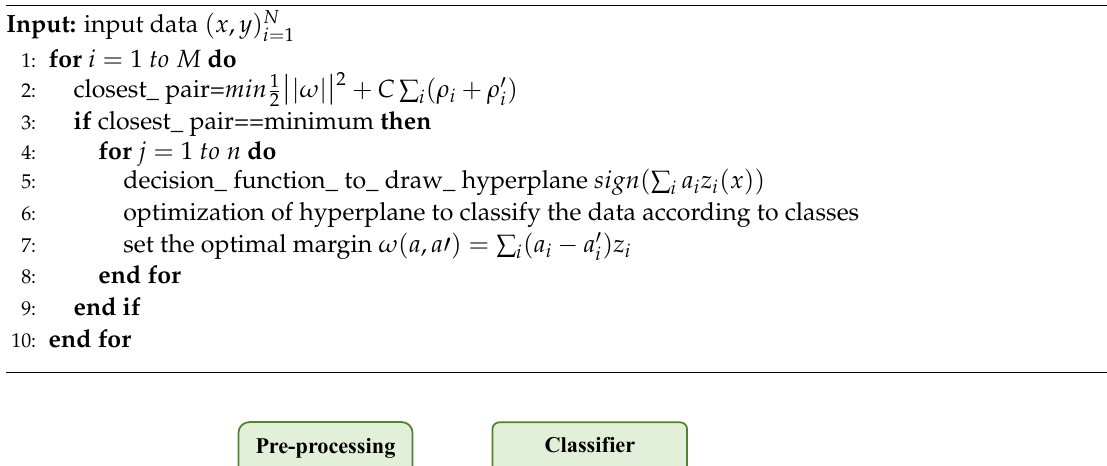
Algorithm 2 Support voting machine.